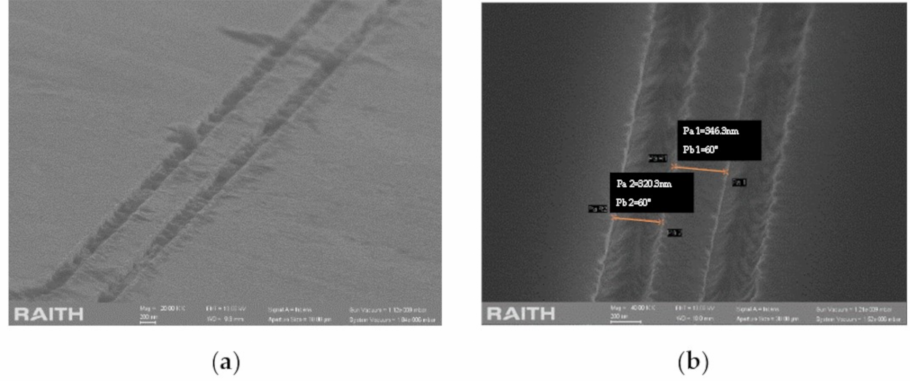
Figure 18. SEM image of etching of ( a ) RIE and ( b )